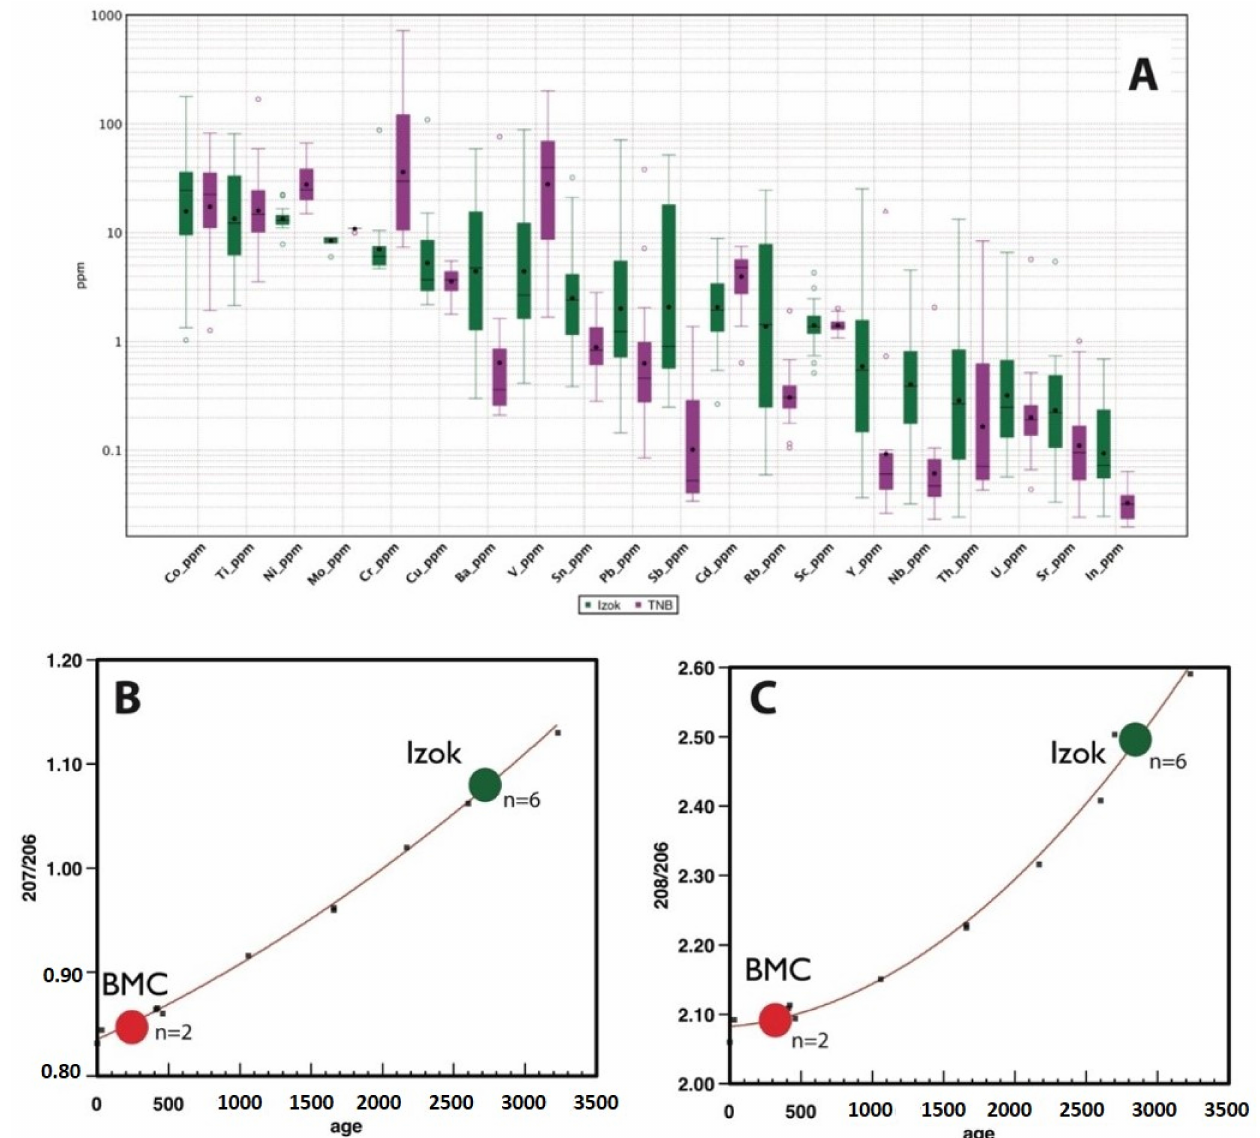
Figure 10. ( A ) Box and Whisker plot of LA-ICP-MS quadrupole trace element data for gahnite from tills from the Izok Lake VMS and the Thompson Ni-Cu PGE deposits areas. ( B ) LA-ICP-MS 207 Pb/ 206 Pb age relations for Izok Lake VMS (green circles) and Halfmile Lake VMS (Bathurst Mining Camp, New Brunswick: red circles). ( C ) LA-ICP-MS 208 Pb/ 206 Pb age relations for Izok Lake VMS (green circles) and Halfmile Lake VMS (Bathurst Mining Camp, New Brunswick: red circles). Red lines are an approximation of terrestrial lead isotopic evolution (Stacey and Kramers 1975) [169]. High-precision U/Pb ages for Halfmile Lake is 465 Ma (van Staal et al. 2003) [170], for is Izok Lake is 2623 ± 20 Ma (Mortensen et al. 1988) [168] and 2680.5 +7/ − 3 Ma (J. Gebert, unpub.